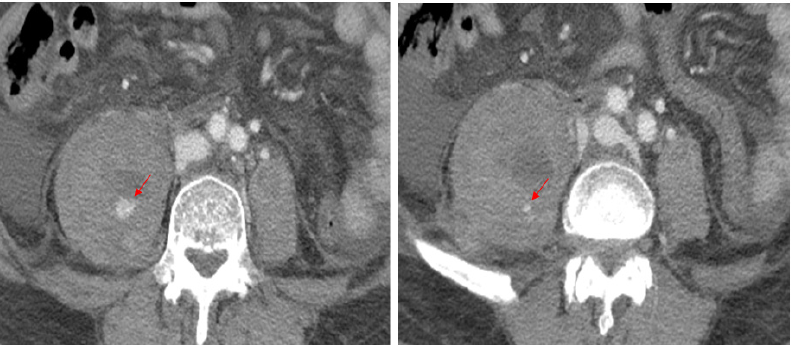
Figure 1. Contrast-enhanced CT scans reveal high attenuation, indicating active bleeding (arrows) from the right second and third lumbar arteries within the hematoma.